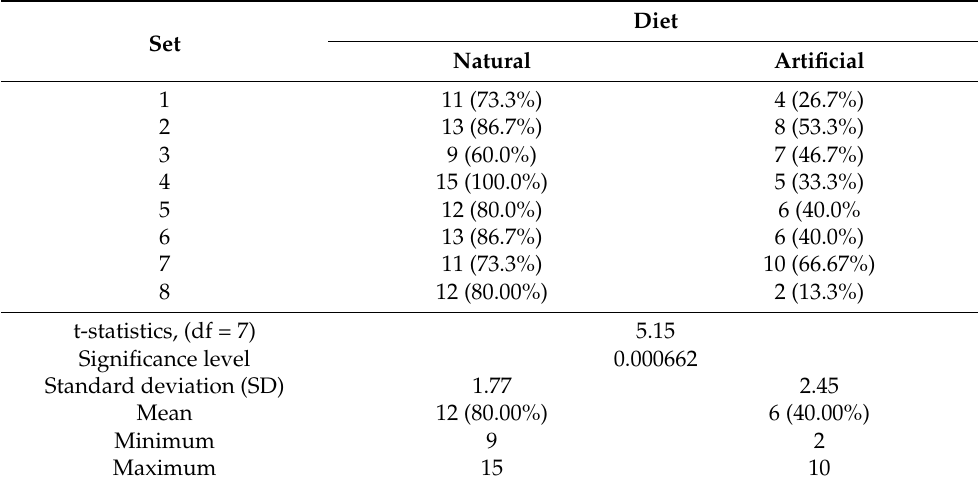
Table 4. Rate of FAW larval survival (% proportion) and significant tests under natural and artifi- cial diets.